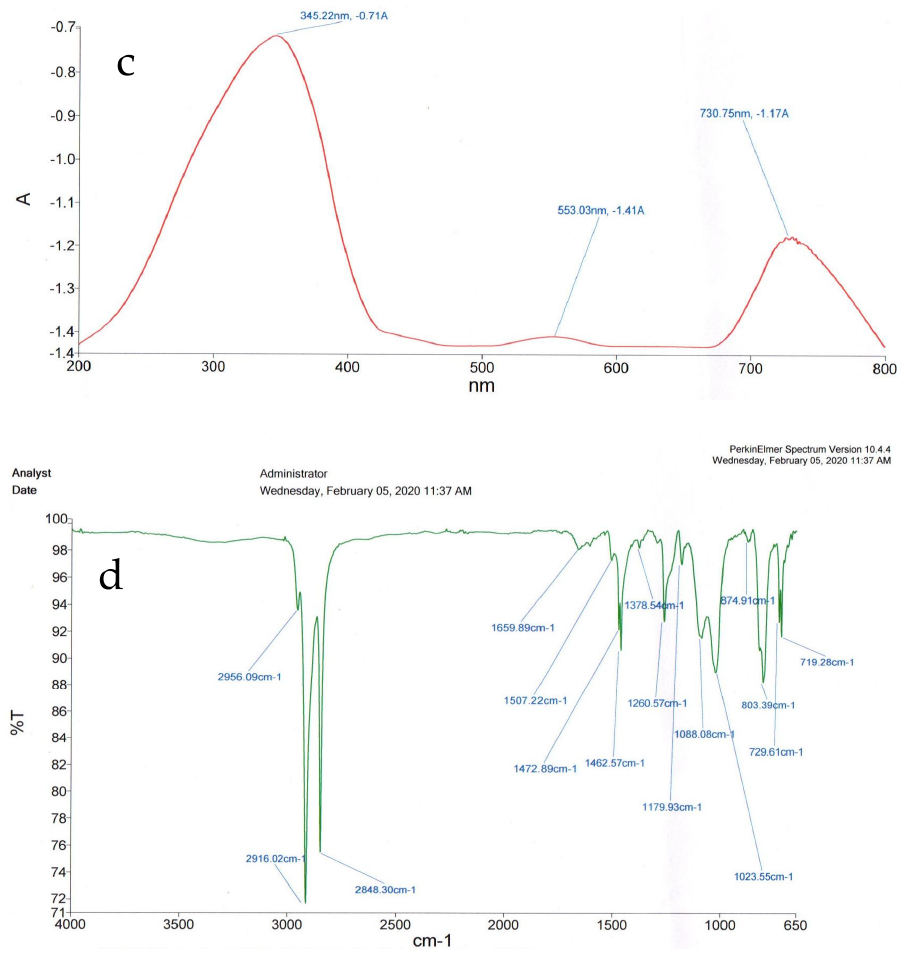
Figure 5. Characterization of JCJC spent tea leaf composites: ( a ) SEM image, ( b ) XRD analysis, ( c ) UV − Vis spectra, and ( d ) FTIR graph. Table 7. Characteristics, chemical properties, functional groups, and vibration types of JCJC spent tea leaf composites.